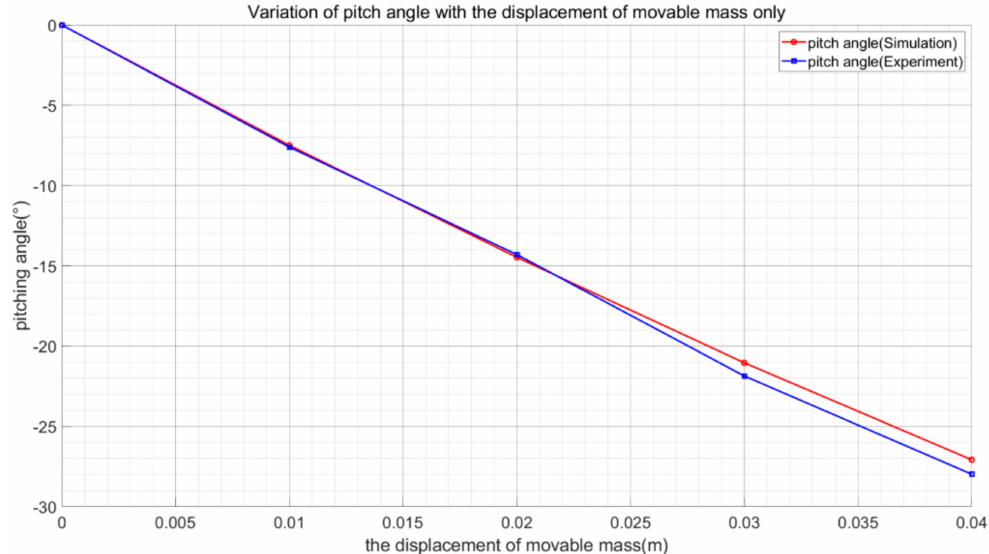
Figure 17. Comparative results of experiment and